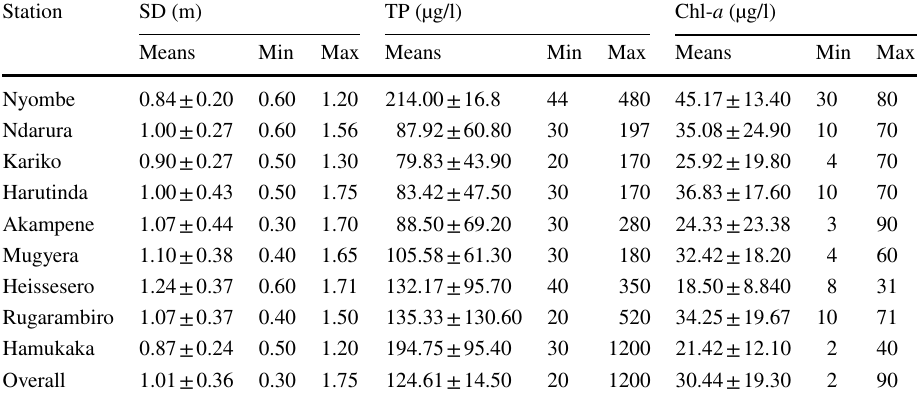
Table 3 Mean ± Std. Dev. and range values of the trophic state indicators during the study period ( n = 108)